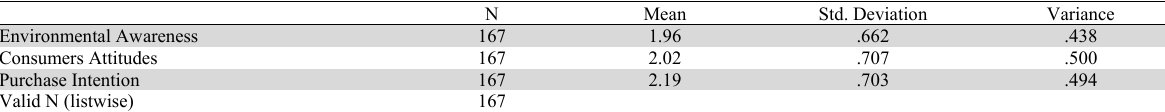
Value of Mean, Variance, and Standard deviation